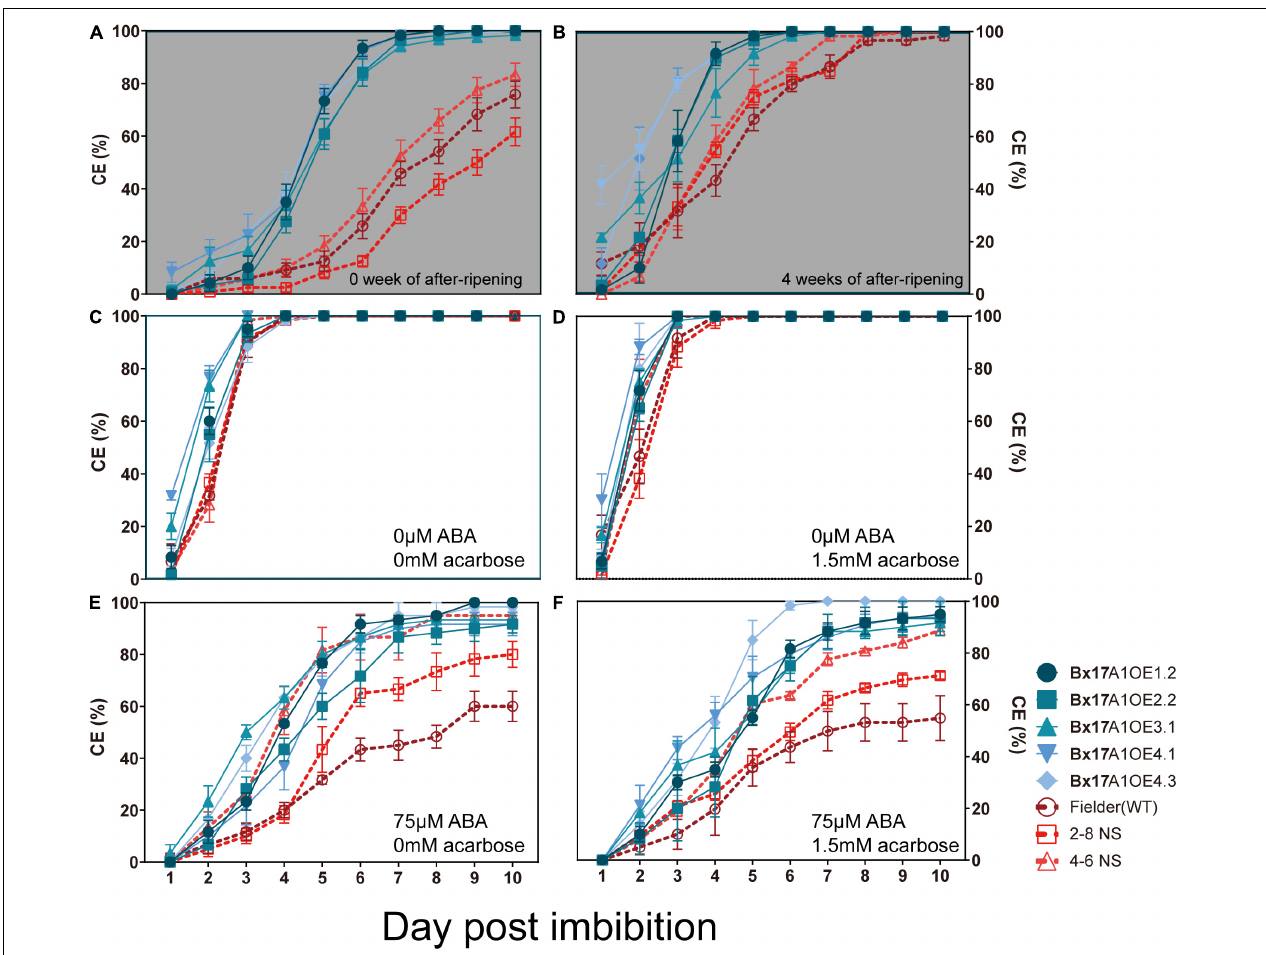
FIGURE 5 | Effect of after-ripening, abscisic acid (ABA) and acarbose on grains germination. Coleorhiza emergence (CE) over days after imbibition for whole grains at physiological maturity (A) and 4 weeks after ripening (B) in whole grains. CE for half grains at physiological maturity in absence of ABA and acarbose (C) , in presence of 1.5 mM of acarbose (D) , 75 µ M of ABA (E) and in presence of both 1.5 mM acarbose and 75 µ M ABA (F) . Germination rate comparisons between five Bx17A1OE lines (blue) and three negative control (red). The blue circle, square, triangle, inverted triangle, and rhombus were indicated Bx17A1OE1.2, Bx17A1OE2.2, Bx17A1OE3.1, Bx17A1OE4.1, and Bx17A1OE4.6, respectively. Red circle, square and triangle were indicated Fielder, 2-8 NS, and 4-6 NS, respectively. Error bars represent Standard Error of three replicate